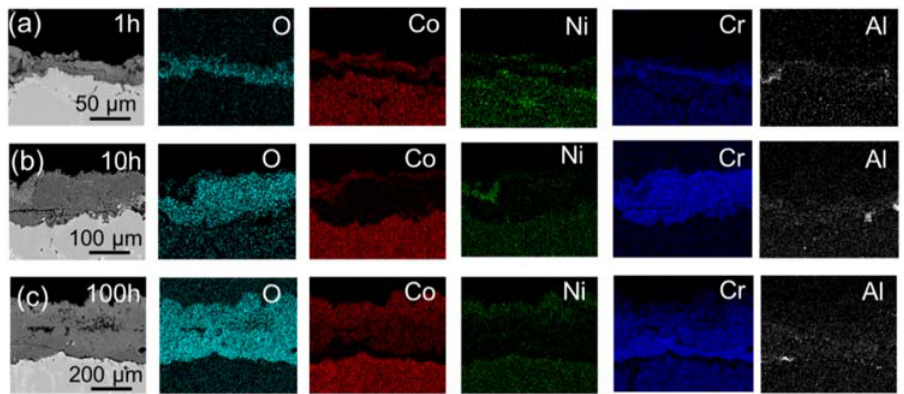
Figure 11. Cross ‐ section morphology and mapping of DZ40M continuous corroded for 1 h, 10 h, and 100 h with NaCl present. (a) 1h, (b) 10h, and (c) 100h.